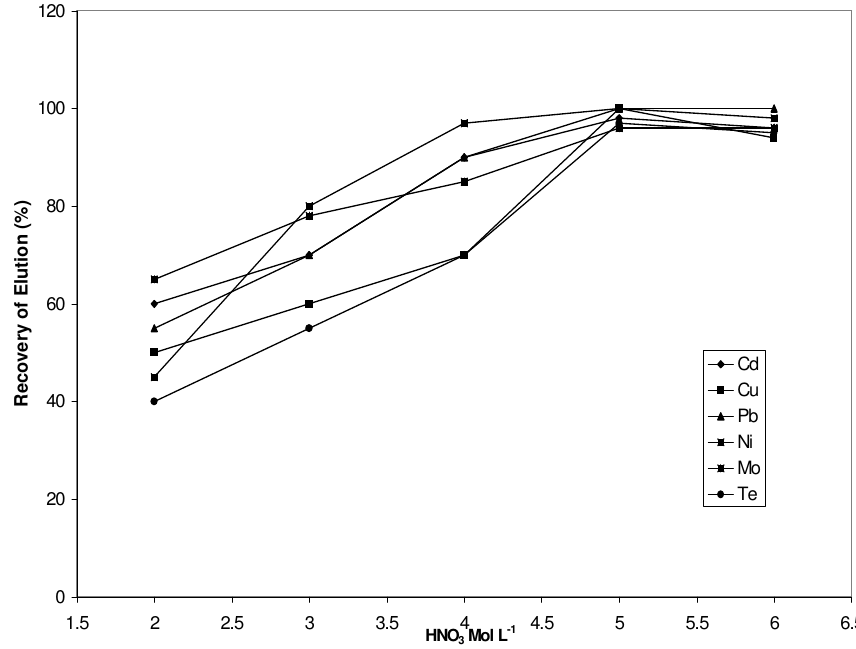
Figure 3. Effect of HNO